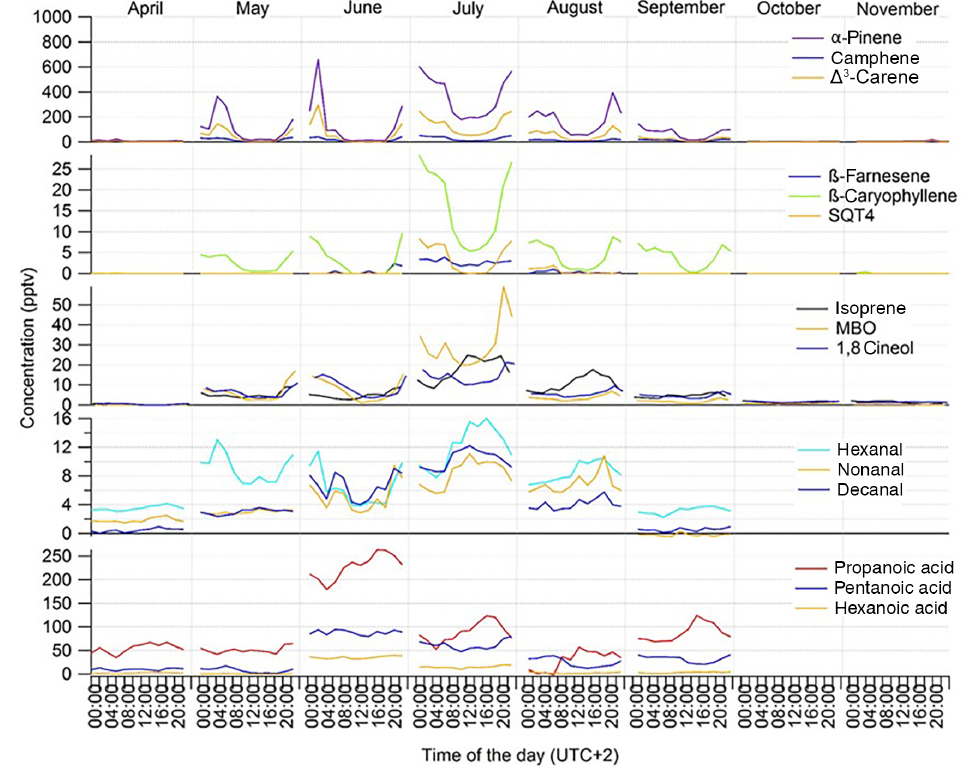
Figure 2. Monthly mean diurnal variation of concentrations of different VOCs at the SMEAR II station in